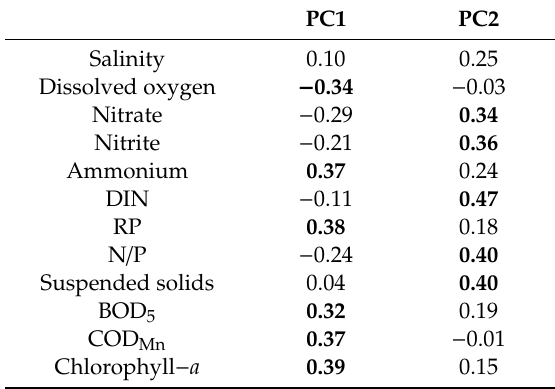
Figure 3. Principal component analysis (PCA) of near-bottom water variables, including salinity, dissolved oxygen (DO), ammonium, nitrate, nitrite, dissolved inorganic nitrogen (DIN = ammonium, nitrate, and nitrite), reactive phosphorus (RP), N/P ratio, suspended solids (SS), biological oxygen demand (BOD 5 ), chemical oxygen demand (COD 5 ), and chlorophyll- a (Chl- a ). PC1 = 46.5% of variance, PC2 = 34.4% of variance. Table 2. Component correlation coefficients in the principal component analysis (PCA) of the water variables and the first two components (PC1 and PC2 = 46.5% and 34.4% of variance, respectively). PC1 PC2